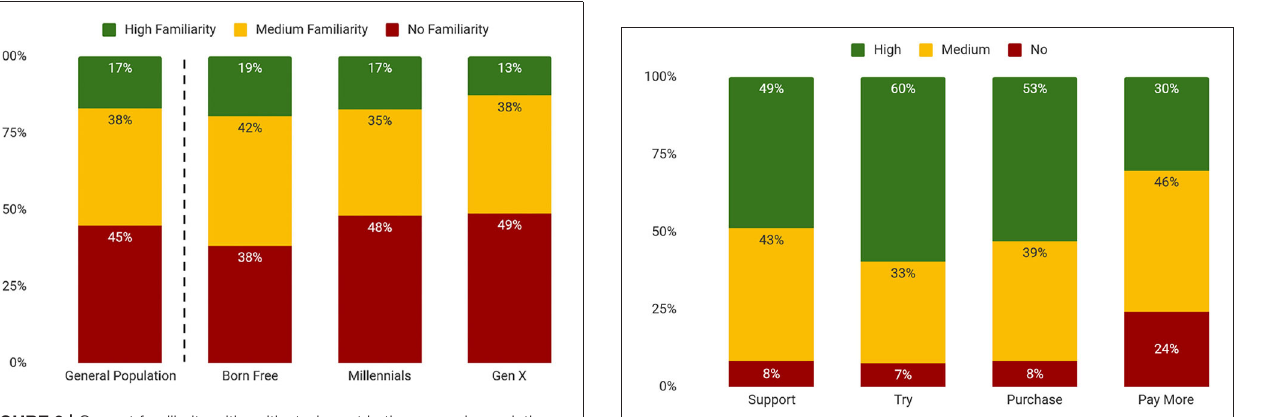
FIGURE 5 | Future adoption of cultivated meat in the general